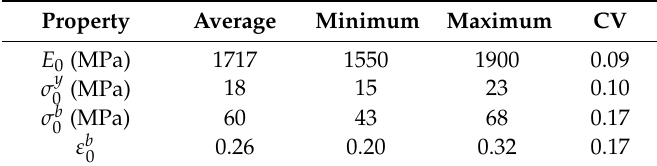
Figure 4. Stress-strain curves of a single fiber. Table 1. Mechanical properties of the silk fibroin (SF)/polycaprolactone (PCL) single fiber.